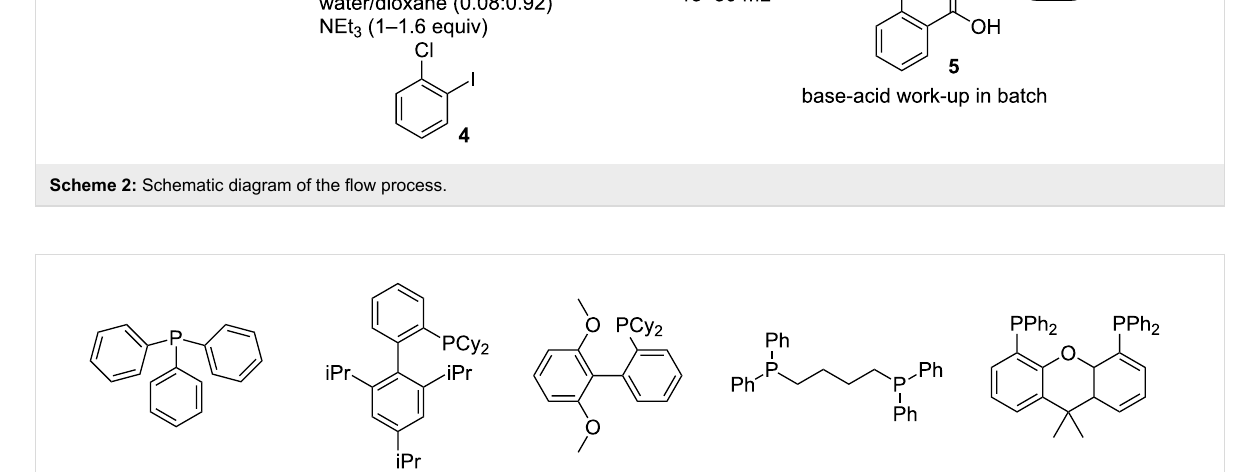
ed yield. However, the highest selectivities for the desired prod- uct were obtained with S-Phos ( 8 ) and triphenylphosphine ( 6 ) (Table 1, entries 2 and 5), with the difference between the conversion and the isolated yield mainly equating to the dehalo- genated product namely,